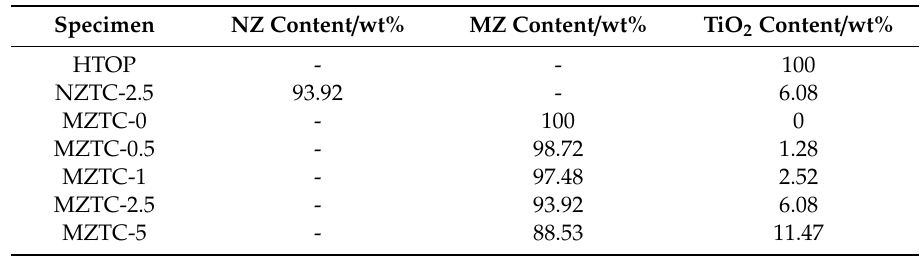
Table 4. Composition of the specimens. (NZTC = natural zeolite / TiO 2 composite; MZTC = modified zeolite / TiO 2 composite; HTOP = hydrolysis TiO 2